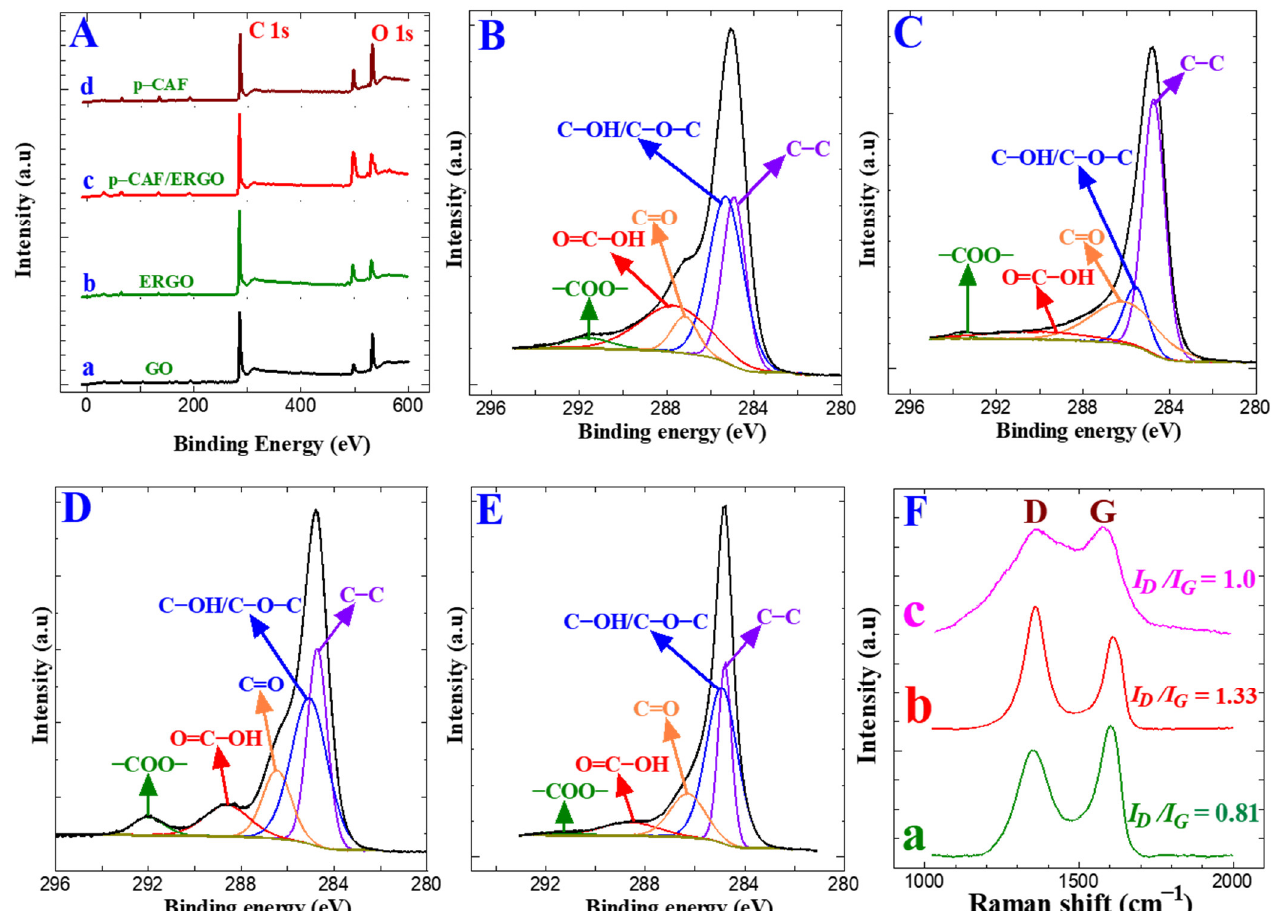
Figure 3. ( A ) XPS survey (a) GO/GC, (b) ERGO/GC, (c) p-CFA@ERGO/GC, and (d) p-CFA/GC, ( B